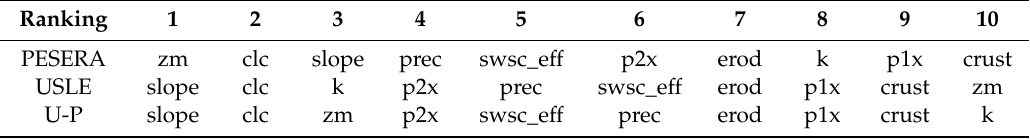
Table 6. Variable ranking based on Random Forest regression analysis.